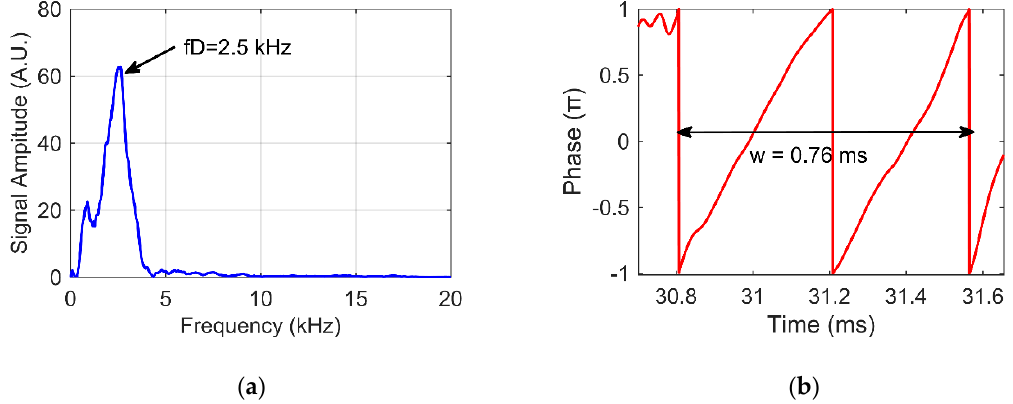
Figure 6. The signal processing of the detected SMI signal burst from a PS bead. ( a ) Fast Fourier transform (FFT) on the frequency domain. ( b ) Hilbert transform (HT) on the time domain.